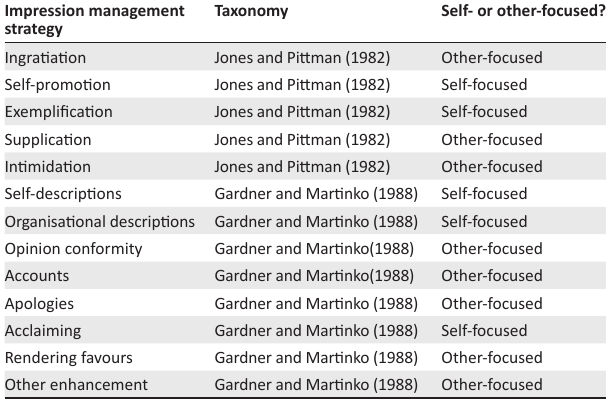
TABLE 1: Focus of impression management